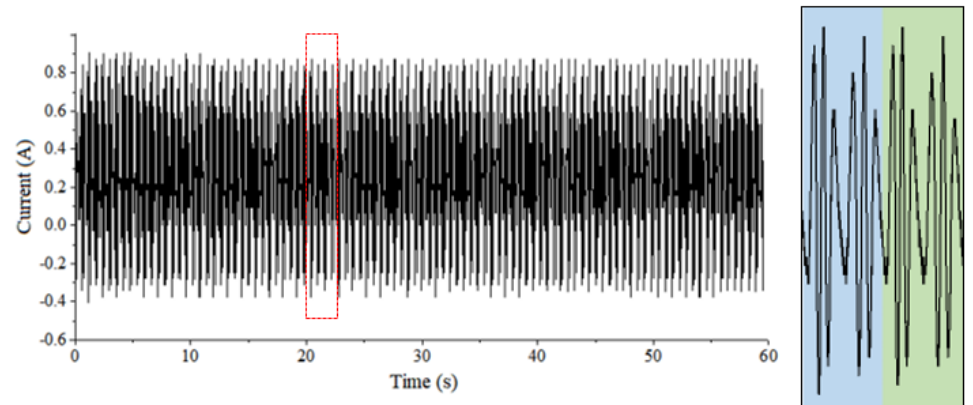
Figure 16. Current diagram (including the zoom-up of the enclosed region between 20.1 s and 22.5 s) under fully standing waves of T / T p = 1.0, h = 0.6 m.